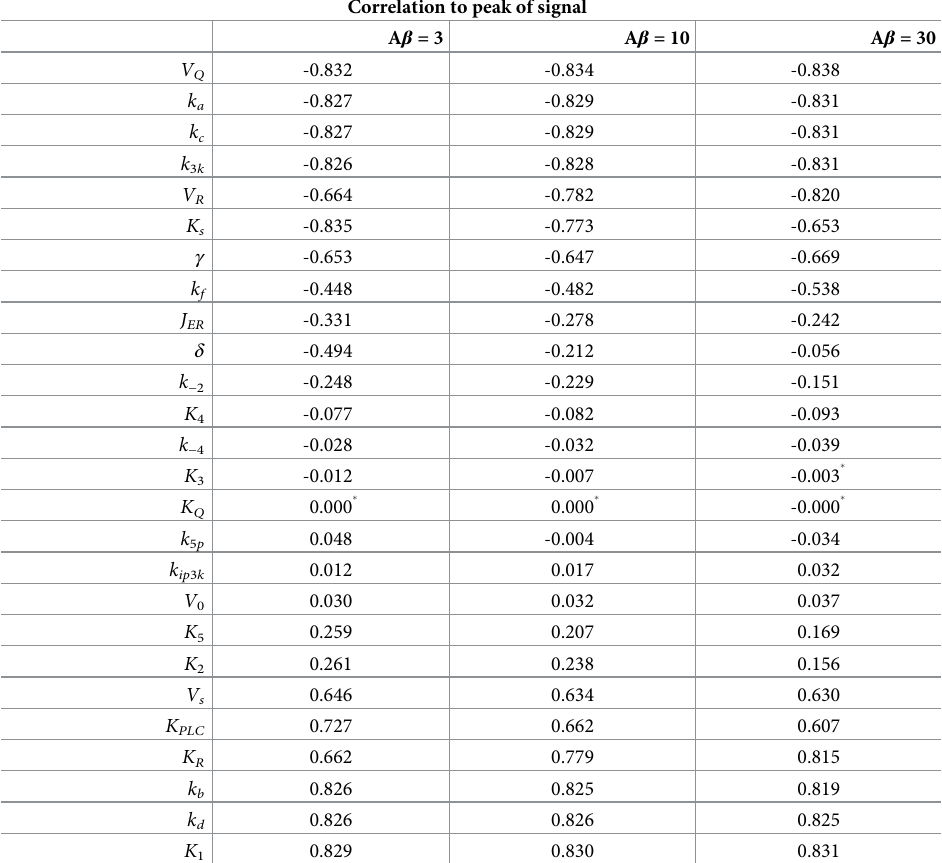
Table 4. Partial rank correlation coefficient sensitivity analysis between model parameters ( n = 100, 000) and the time to peak when maximum Ca 2+ concentration was reached for each of the three levels of large doses of A β con- centration. � indicates the correlation coefficient is not significant at the p = 0.05